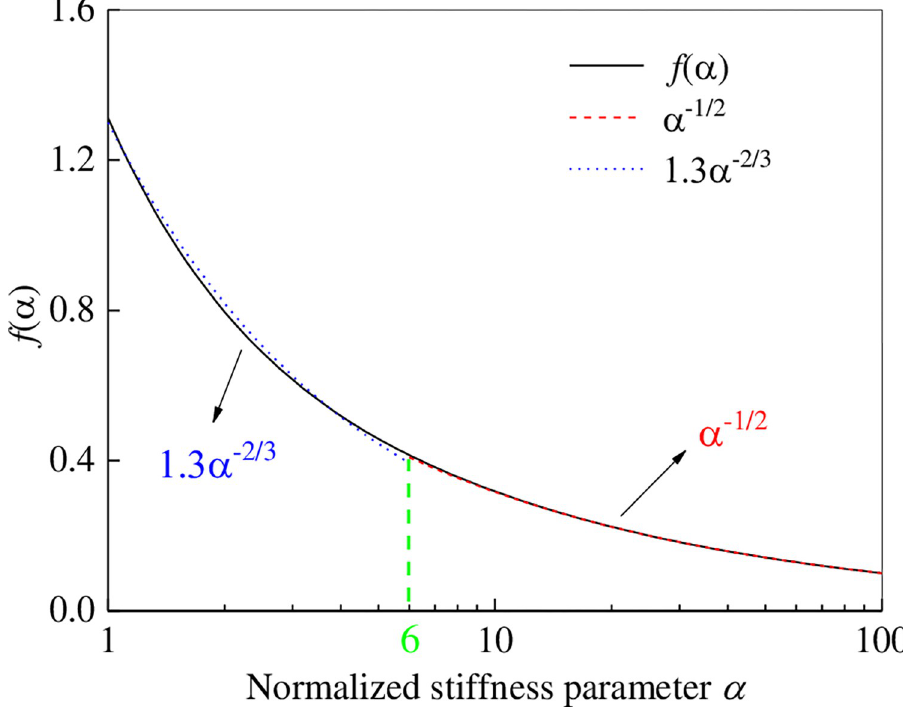
Fig 7. Relationship between f ( α ) and α